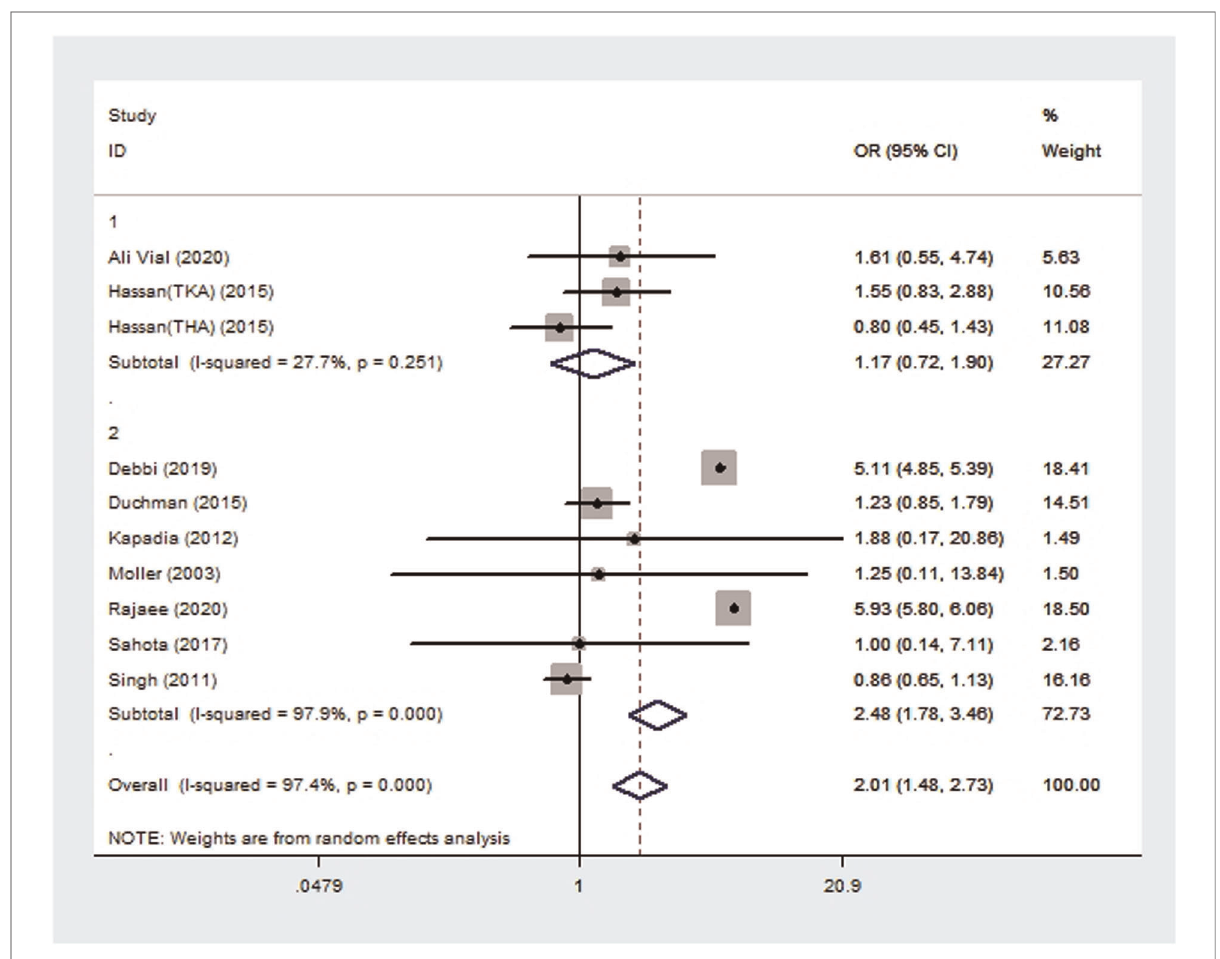
FIGURE 8 Forest plot of subgroup analysis for acute renal insuf fi ciency based on study type (1: case-control study; 2: cohort